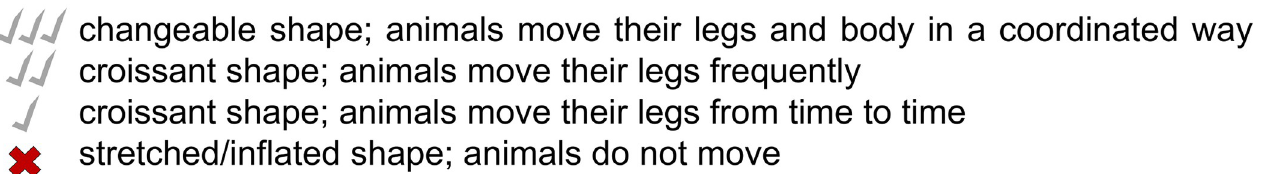
Fig 2. Toxicity in vivo test indicates AOX contribution to functioning of H . exemplaris specimens in the absence and in the MRC cytochrome pathway inhibition. Adult active specimens of a comparable body length and cleaned of debris were treated with KCN (1 mM) and BHAM (3 mM) in different configurations. Animals were observed after 30 min, 45 min and 2 h, and the medium was not replaced till the end of the test. The upper and lower parts of the figure provide graphic representations and images of the treated animals’ appearance indicating their body shape changes co-occurring with mobility changes, respectively. The data represent two independent repeats of the test lasting for 2 h and each tested group consisted of 20 specimens (see also Additional file 1 for the performed controls for the MRC cytochrome pathway inhibition by KCN and applied solvents as well as images of animals during and at the end of the test; see also Additional file 2 for recorded films presenting animals after 45 min of the